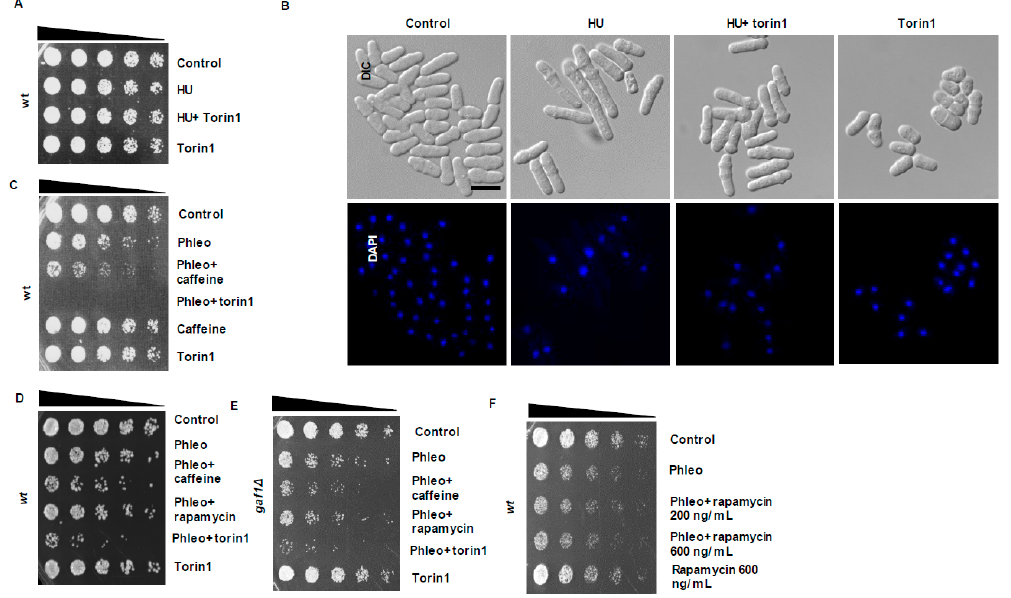
Figure 5. Inhibition of TORC1 overrides checkpoint signalling similarly to caffeine. ( A ). Wt cells were incubated with 20 mM HU for 2 h. The cultures were then incubated for a further 2 h in the presence of 10 mM caffeine as indicated. Cultures were adjusted for relative cell numbers, serially diluted and plated unto YES agar plates. Plates were incubated at 30 °C for 2–3 days. ( B ). Cells in A were fixed in 70% ethanol, stained with DAPI and examined by differential contrast microscopy. Scale bar 10 µM ( C ). Wt cells were incubated with 10 µg/mL phleomycin for 2 h. The cultures were then incubated for a further 2 h in the presence of 10 mM caffeine or 7.5 µM torin1 as indicated. Cultures were adjusted for relative cell numbers, serially diluted and plated on YES agar plates. Plates were incubated at 30 °C for 2–3 days. ( D ). Wt cells expressing Wee1-HA, were incubated with 5 µg/mL of phleomycin for 2 h. The cultures were then incubated for a further 2 h in the presence of 10 mM caffeine, 200 ng/mL rapamycin or 5 µM torin1 as indicated. Cultures were adjusted for relative cell numbers, serially diluted and plated on YES agar plates. Plates were incubated at 30 °C for 2–3 days. ( E ). gaf1 Δ mutant cells were incubated with 5 µg/mL of phleomycin for 2 h. The cultures were then incubated for a further 2 h in the presence of 10 mM caffeine, 200 ng/mL rapamycin or 5 µM torin1 as indicated. Cultures were adjusted for relative cell numbers, serially diluted and plated on YES agar plates. Plates were incubated at 30 °C for 2–3 days. ( F ). Wt cells were exposed to 5 µg/mL of phleomycin for 2 h. The cultures were then incubated for a further 2 h in the presence of 200 ng/mL or 600 ng/mL rapamycin as indicated. Cells exposed to 600 ng/mL rapamycin served as a control. Cultures were adjusted for relative cell numbers, serially diluted and plated on YES agar plates. Plates were incubated at 30 °C for 2–3 days.